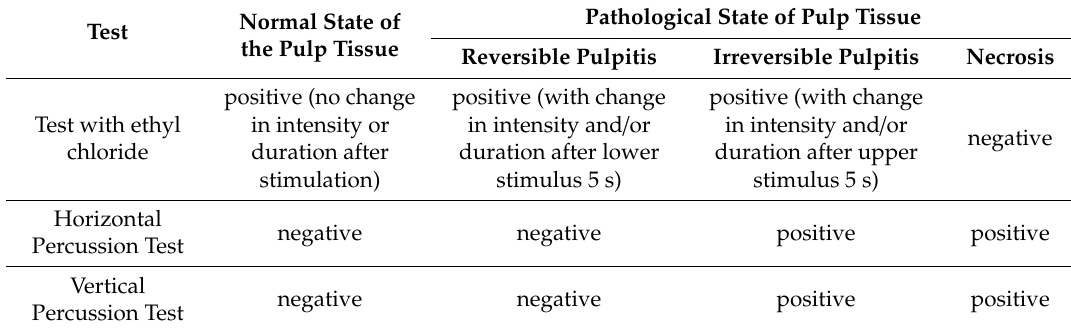
Table 1. Qualitative evaluation criteria for the pulp sensitivity tests.